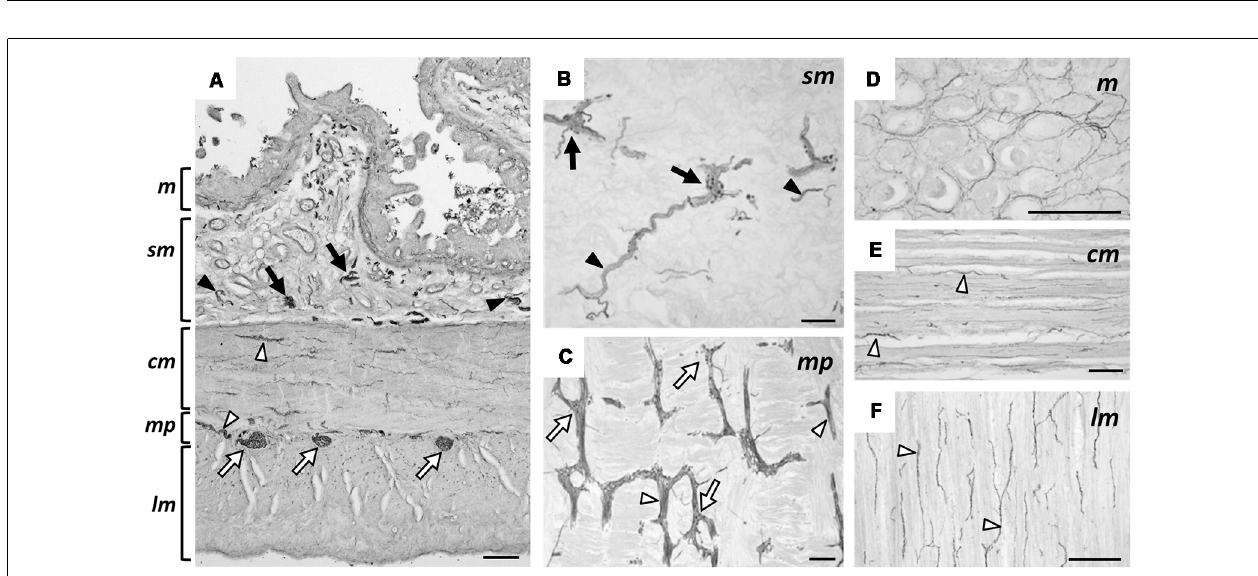
FIGURE 6 | Immunohistochemical staining using hpChAT antiserum in human ascending colon. A transverse section showing the entire layer thickness of colon (A) . In (B–F) , sections were cut longitudinally parallel to the serosa; positive hpChAT-ir labeling seen in submucosa (B) , myenteric plexus (C) , mucosa (D) , circular muscle layer (E) , and longitudinal muscle layer (F) . Arrows and arrowheads indicate ganglionated plexus and nerves fibers bundles, respectively, in submucosa (black) and muscularis propria (white). cm: circular muscle, lm: longitudinal muscle, m: mucosa, mp: myenteric plexus, sm: submucosa. Bars = 200 µ m.